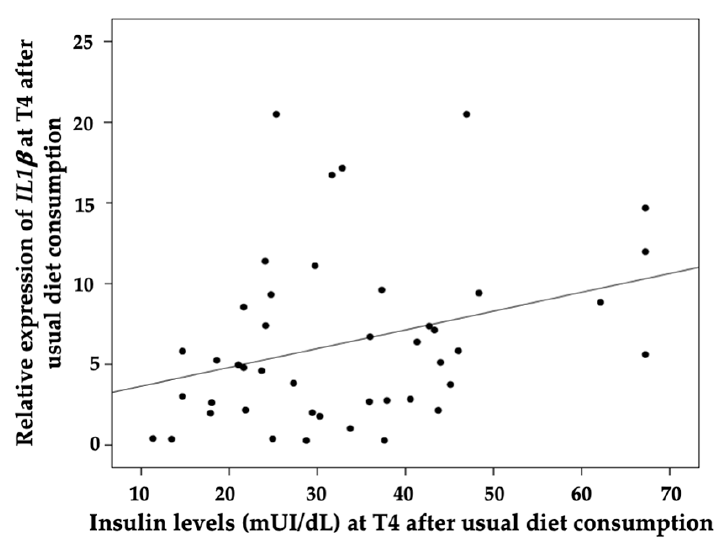
Figure 5. Correlation analysis between the gene expression of the inflammatory-related IL1 β and the insulin levels in the postprandial state at 4 h after 8 weeks of intake of a usual diet. Correlation was evaluated with a Pearson bivariate correlation analysis using SPSS 20 for Windows software (SPSS Inc., Chicago, IL, USA). p < 0.05 was considered to be significant.